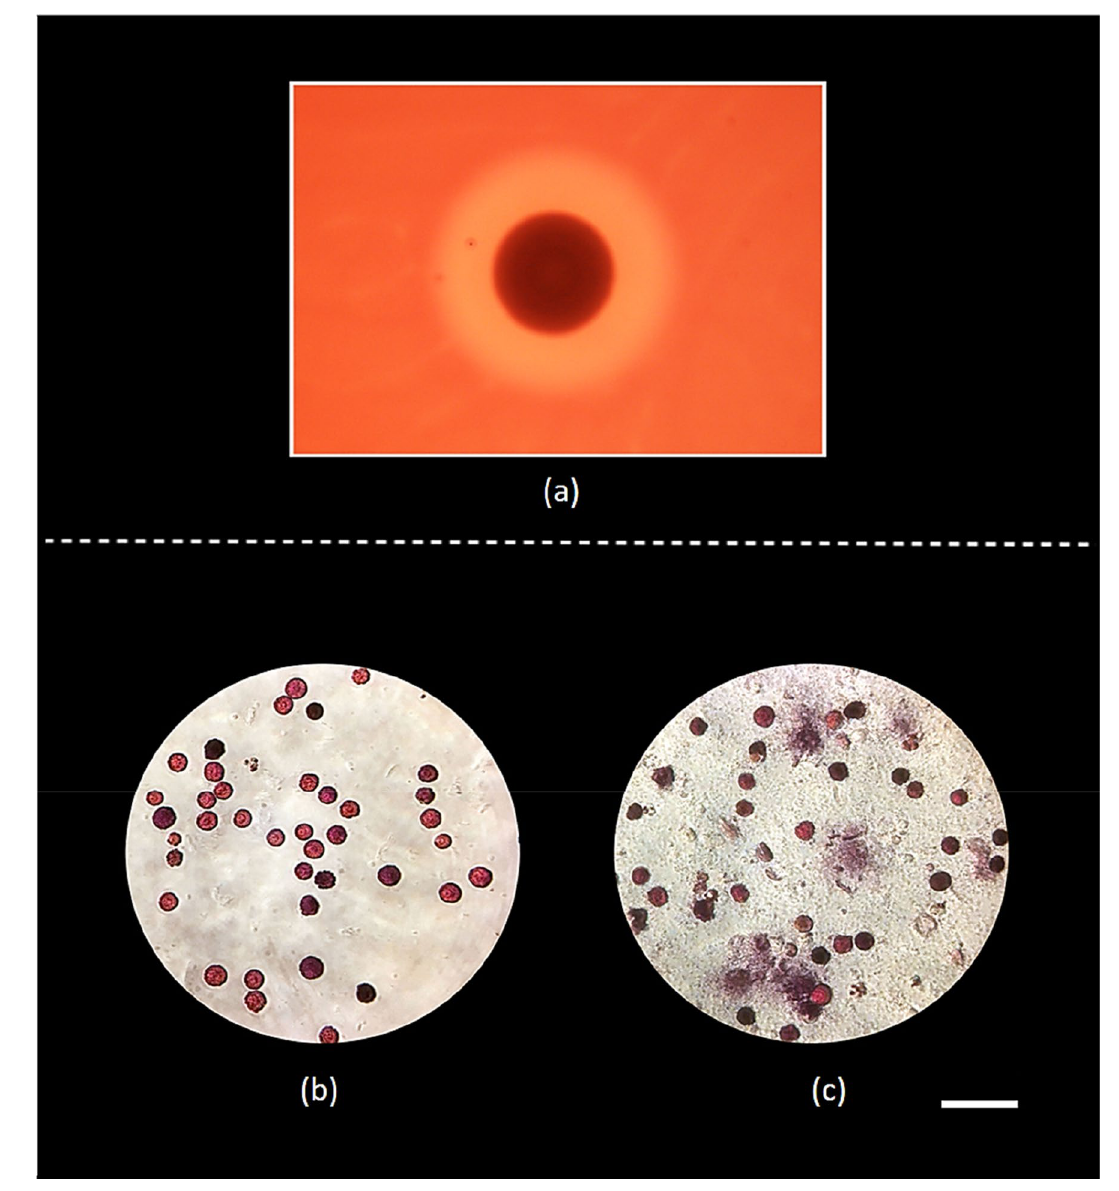
Figure 4. Cytolytic properties of V. echinoideorum towards sheep RBCs and sea urchin RSCs. ( a ) Hemolysis reaction against sheep RBCs is presented here with a clear zone around the colony (16 mm in diameter zone) on blood agar. ( b ) Control with RSCs not exposed to bacteria, ( c ) RSCs exposed to bacteria. Scale bar 60